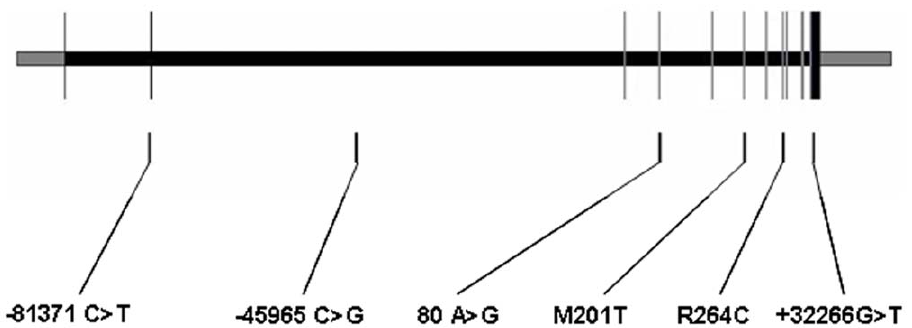
Figure 1. CYP19A1 schematic with SNP locations. Exons are shown as vertical lines (noncoding in black coding in grey), introns are shown as the horizontal space between exons. SNP positions are indicated by vertical lines below the figure.